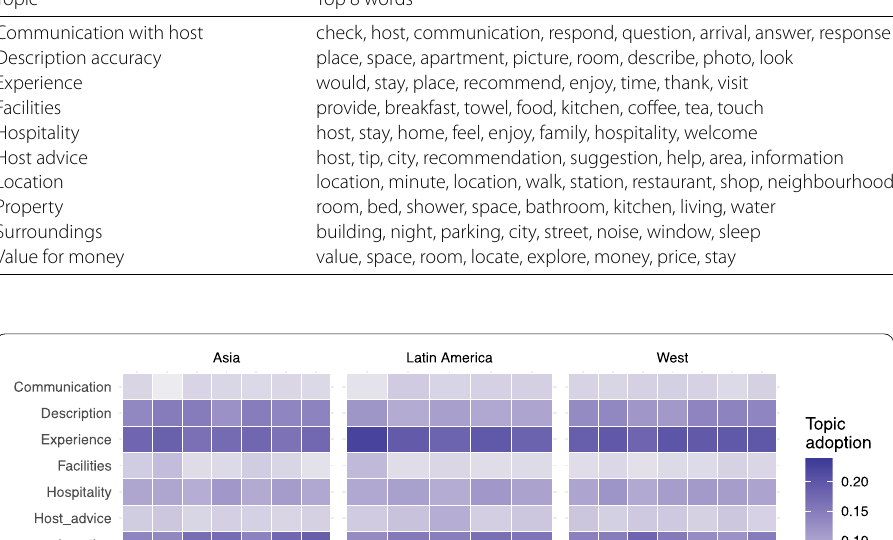
Table 2 10 detected topics and their 8 most relevant words Topic Top 8